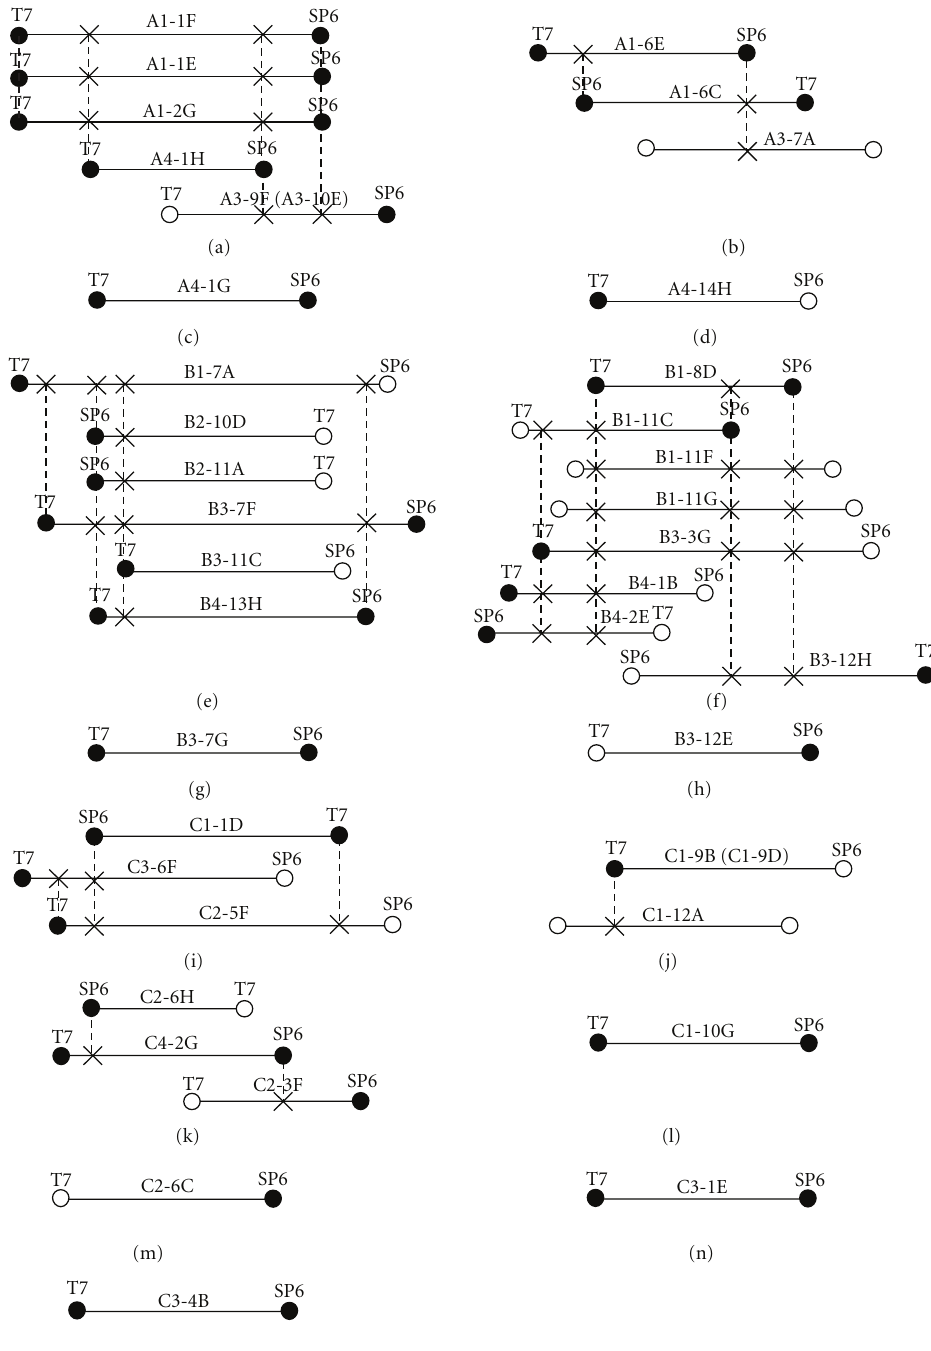
Figure 1: Contig maps for PERV-positive BAC clones using primers designed from BAC end-sequences. Fifteen PERV containing contig maps were constructed in this study ((a)–(d)) PERV-A type; ((e)–(h)) PERV-B type; ((i)–(o)) PERV-C type) and five contigs ((c,) (g), (l), (n) and (o)) were identified as singletons. Solid circles indicate that primers were designed from the BAC end-sequences and open circles indicate that no primers were designed from the BAC end-sequences due to the repetitive sequences. Also, the presence of common BAC end-sequences among the PERV-positive BAC clones is indicated by cross